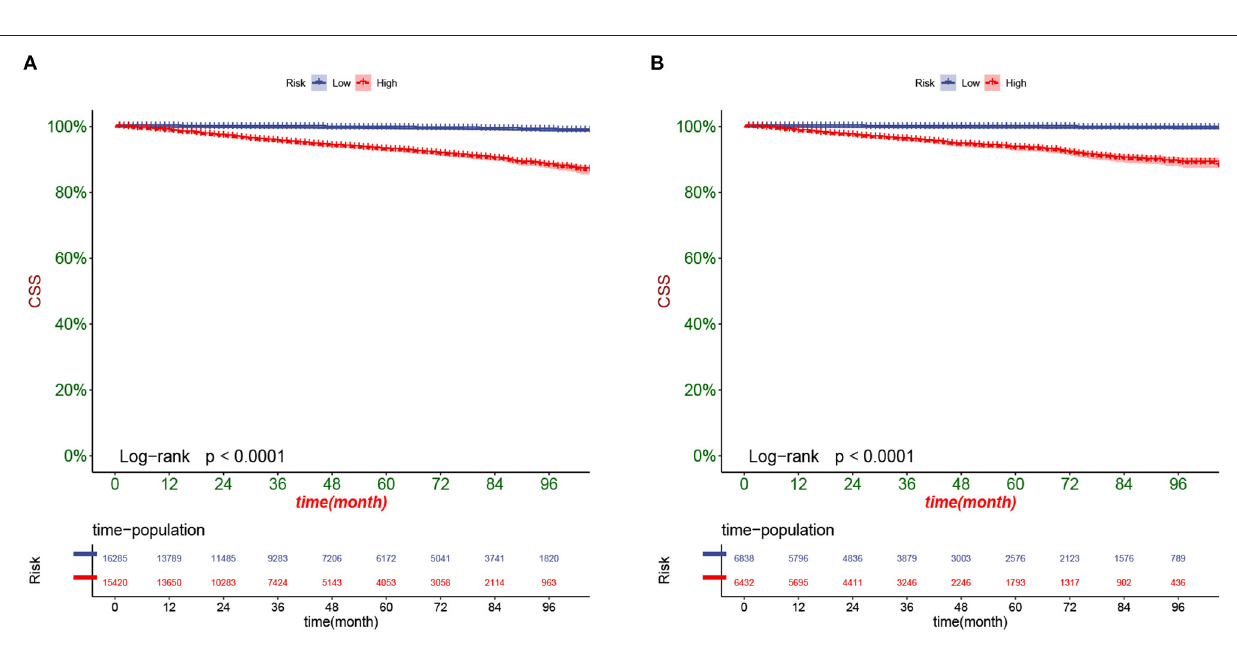
elderly PC patients over 65 years (35). After nearly 20 years of follow-up of men with localized PC, Timothy J Wilt et